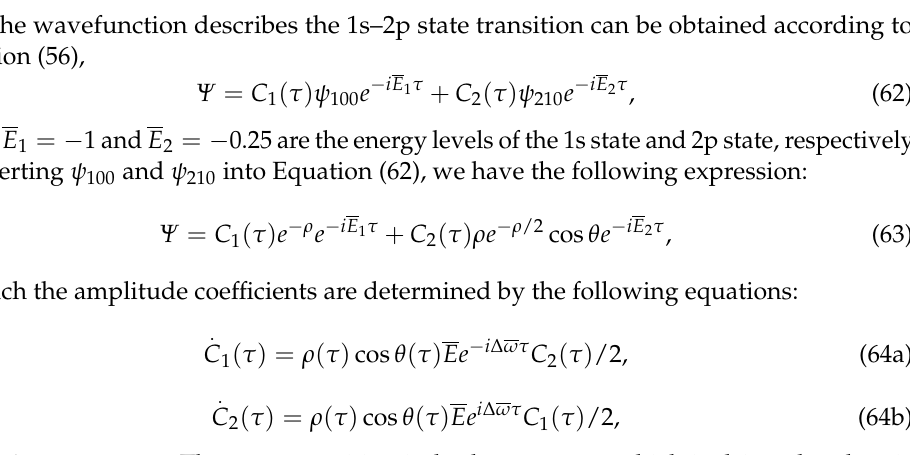
(cid:0) (cid:1) S ↑ , respectively; ( b ) The